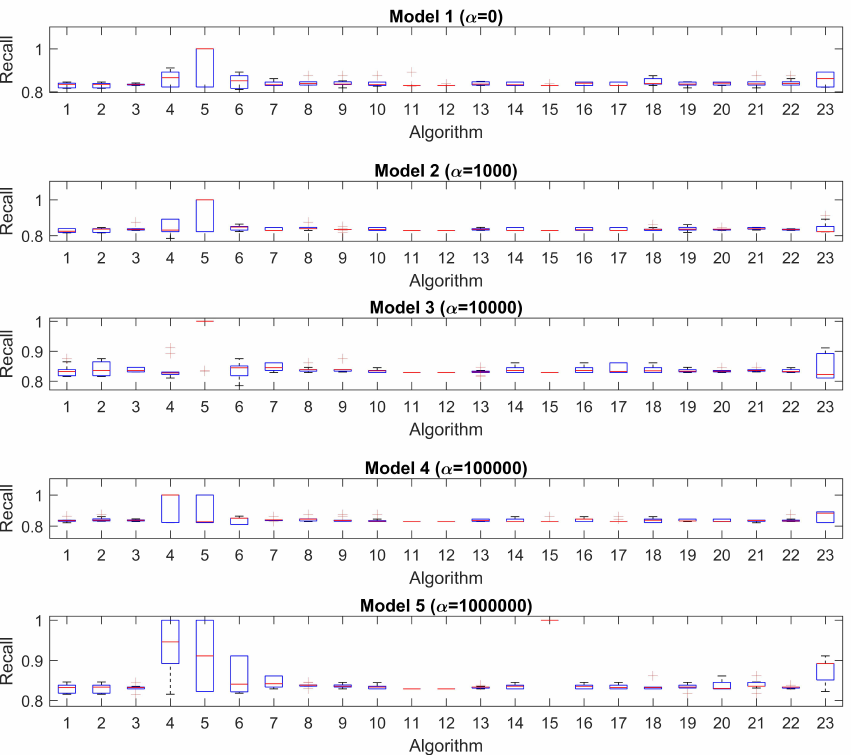
Figure A2. Numerical simulation Assumption 1. Recall of models after increasing the translation constant α for all the 23 algorithms. The 23 algorithms are represented in the x -axis, and the accuracy is shown in the y